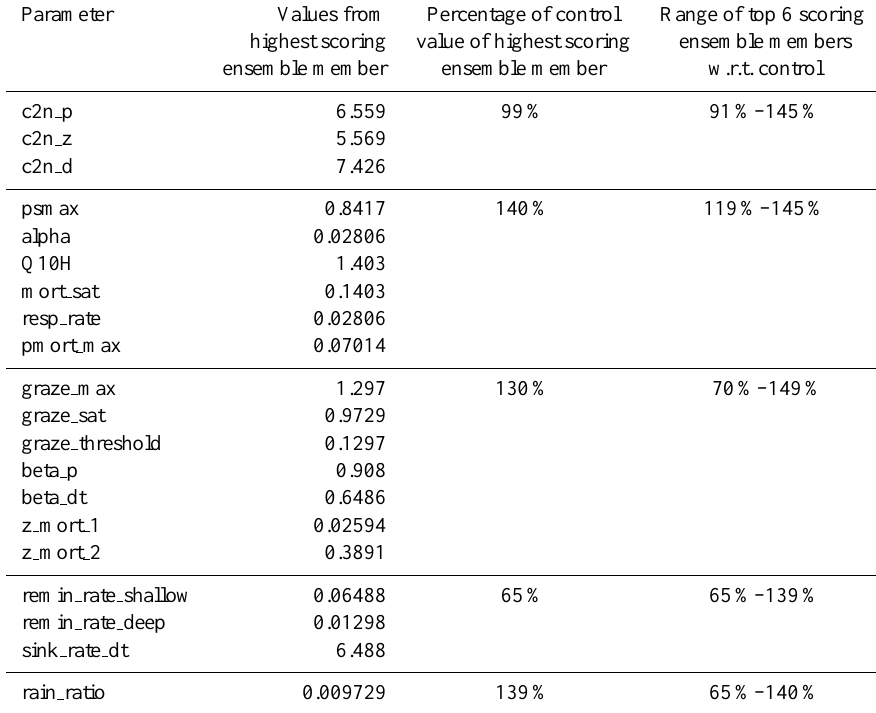
Table 3. Parameter values for the highest scoring ocean carbon cycle ensemble member and their relationship to the respective control value. Also shown is the percentage of the control value which is covered by the top six scoring ensemble members, as shown in Fig.